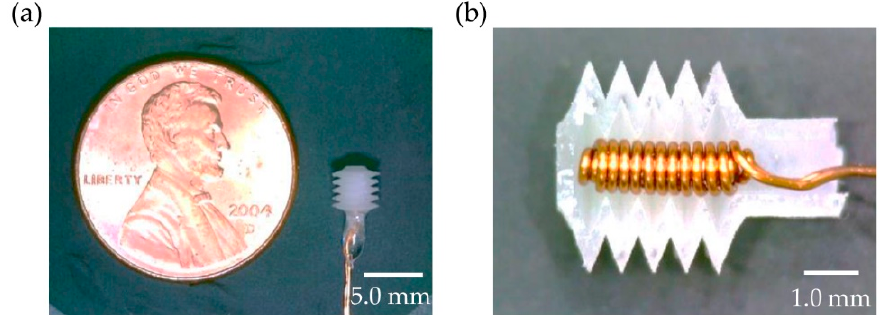
Figure 3. ( a ) Fabricated thermopneumatic bellows actuator. ( b ) Cross-section of the bellows actua- tor with the coil heater. with the coil